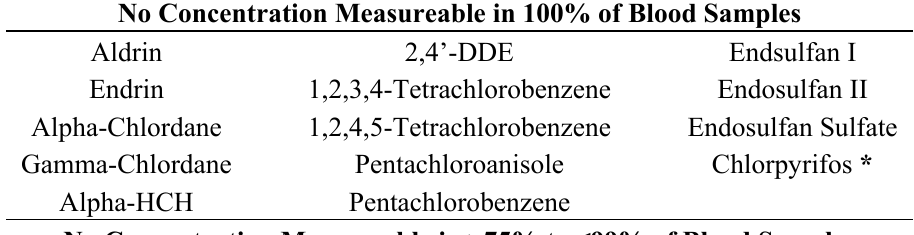
Table 2. Summary of OC analytes either not found or infrequently measurable in maternal and cord